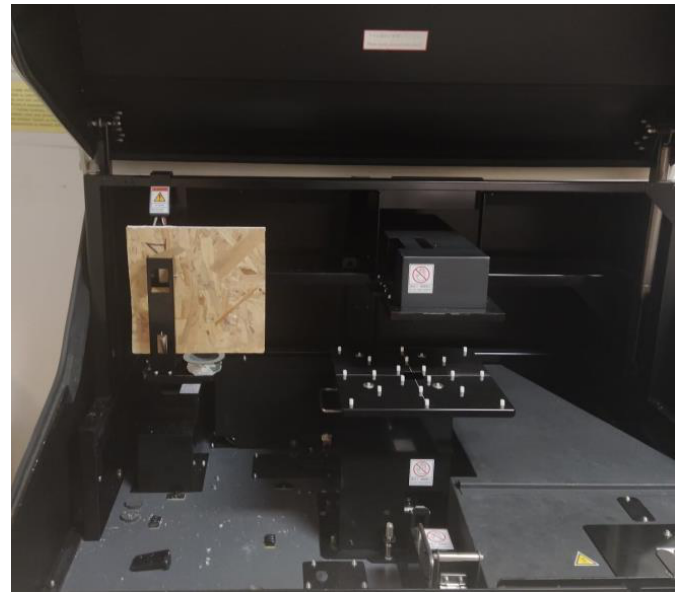
Figure 2. Spectrophotometric analysis of the tested samples.